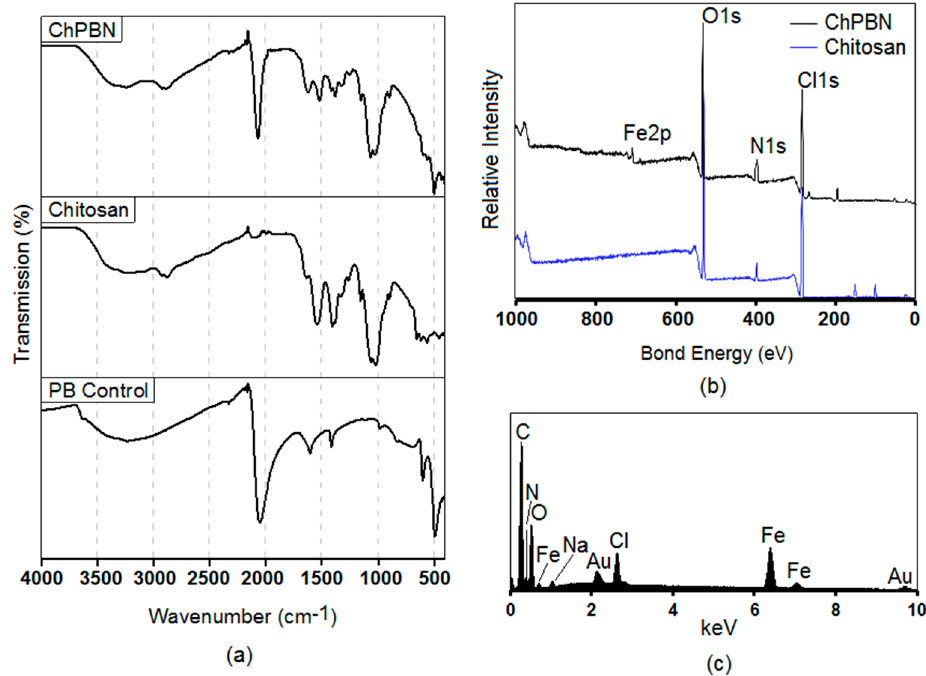
Figure 3. Chemical analysis of ChPBN nanocomposite: ( a ) FTIR spectra for ChPBN in comparison to chitosan and PB; ( b ) XPS spectra of ChPBN compared with chitosan showing the characteristic Fe 2p peaks indicating PB incorporation within the chitosan matrix; ( c ) EDS spectrum of ChPBN.